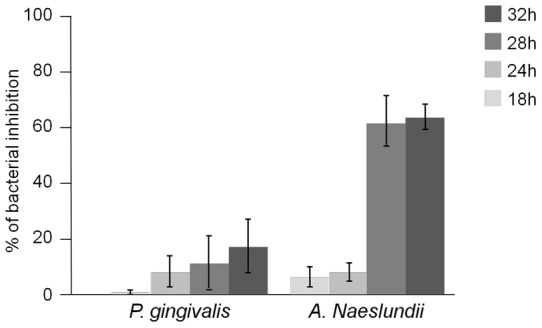
The effects of chitosan coated Ti.on Porphyromonas gingivalis and on Actinomyces naeslundii in liquid medium for 32 hours. Data are expressed in % of bacteria in contact with coated sample compared to the bacteria in contact with control (or percentage of bacterial inhibition). Data represent the means ± SD of three independent experiments. * p<0.01.